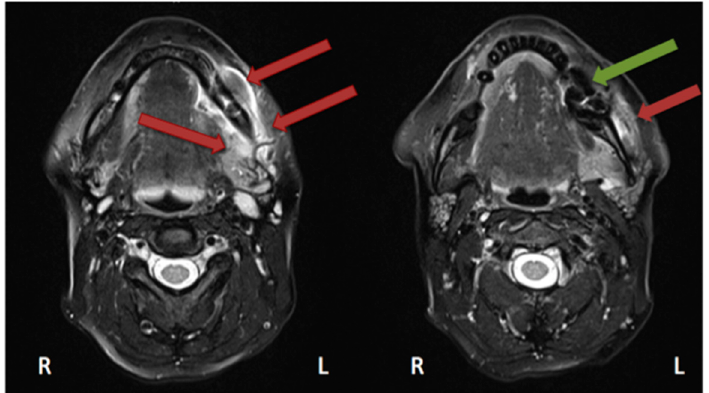
Figure 7. Magnetic resonance imaging (Siemens, Avanto, 1.5T, Sequence: T2 tse tra) Patient: 48 years old, female, metastatic breast cancer, zoledronic acid for 2 years (panoramic radiograph Figure 1). Green arrow showing the MRONJ necrosis: hypointense bone marrow, red arrows showing the oedema. Pair of screenshots. AAMOS staging: stage 2.